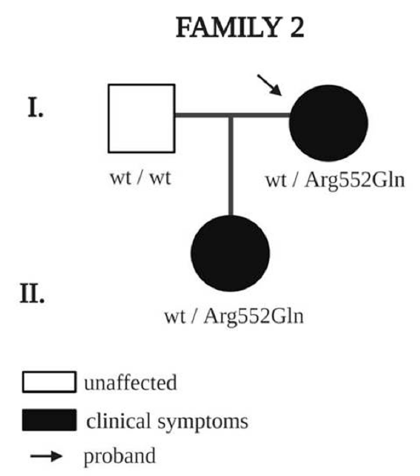
Figure 1. Pedigree of family 2 with a rare NRP1 variant. Square indicates male, and circles indicate females; black indicates clinical symptoms of lymphedema. Arrows indicate probands, and wt indicates wildtype amino acid.